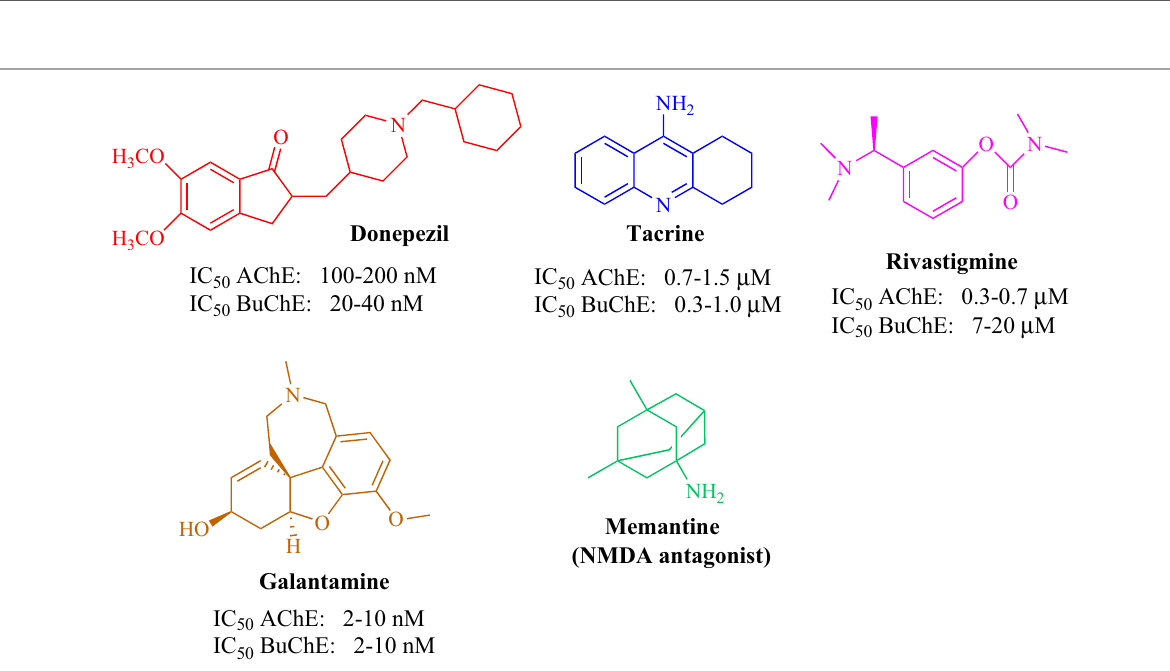
Fig. 36 Marketed anti-AD drugs. For cholinergic drugs, inhibitory activity ranges on AChE and BuChE are